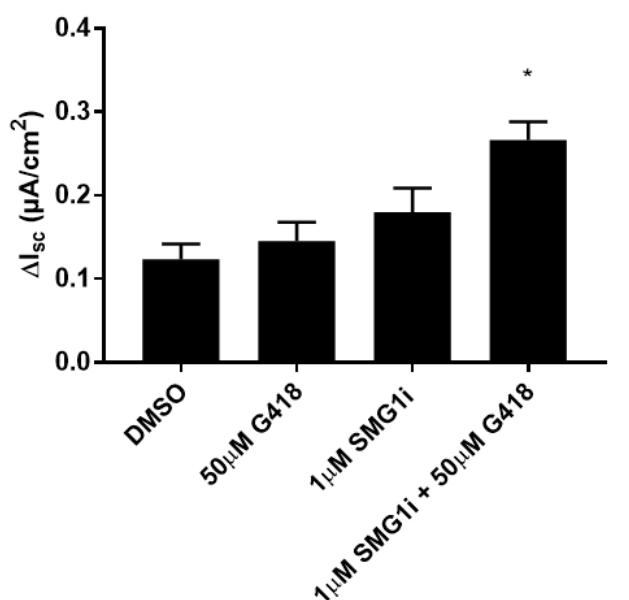
Figure 5. SMG1i synergizes with readthrough in trachea tissue. ( A ). Representative Isc traces of G542X trachea monolayers treated with DMSO or a combination of 50 µM G418, and 1 µM SMG1i for 48 h prior to treatment with compounds as indicated. Subsequent CFTR stimulation, potentiation and inhibition were achieved through the addition of forskolin, genistein, and CFTRinh172 ( B ). Changes in Isc after stimulation with 10 µM forskolin for the indicated treatment groups. n = 3–11, * p < 0.05.